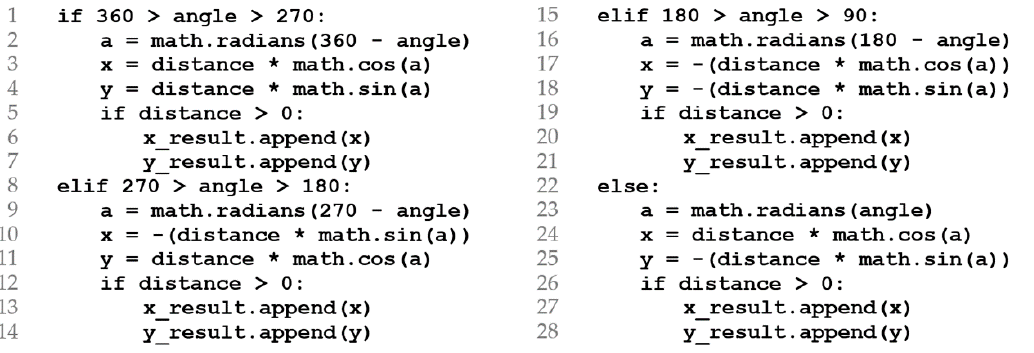
Figure 35. Python code for generation of two-dimensional drawing using angle and distance data obtained from RPLidar A2 lidar sensor.